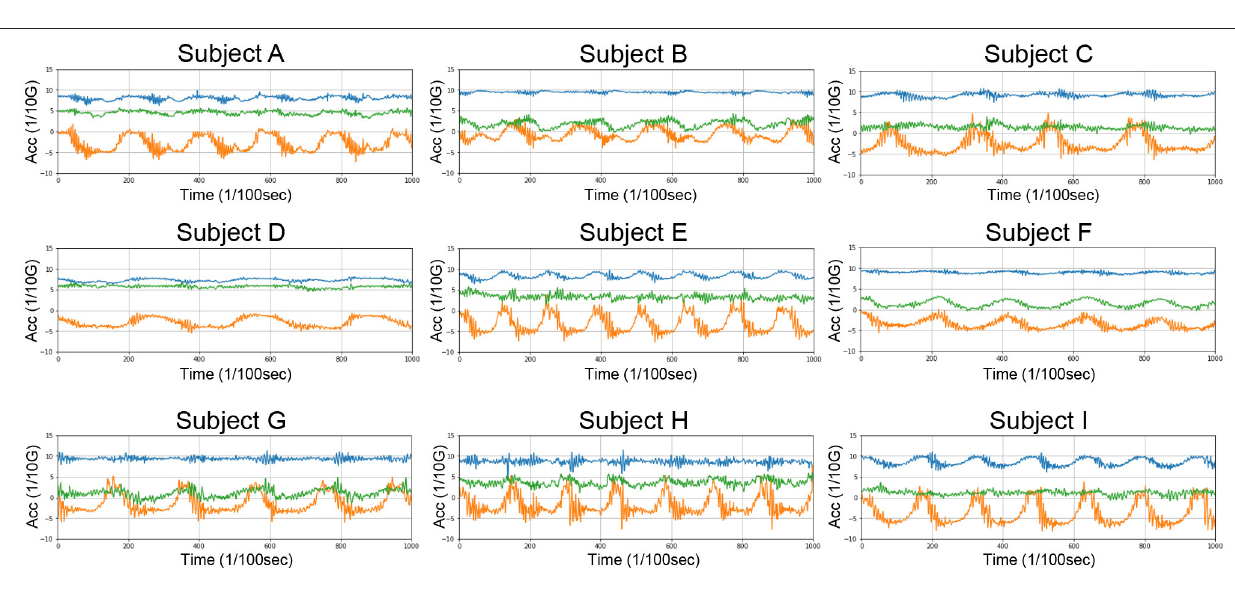
FIGURE 2 | Smartwatch acceleration sensor data regarding push-up actions from nine participants, indicating the individual differences in sensor data. Blue, orange, and green lines indicate x-, y-, and z-axis sensor data,